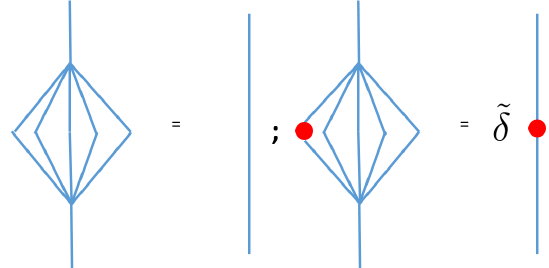
Figure 45. The imperfect tensor is any isometry with 1 input and 5 outputs. An X operator insertion into this contracted isometry leads to another X operator times some constant multiplica- tive factor ˜ δ